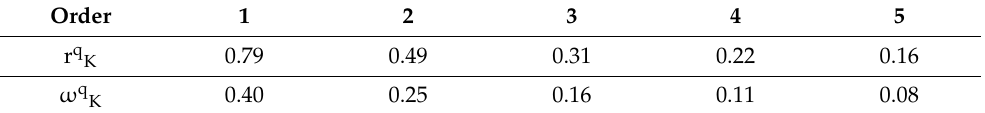
Table 12. Correlation coefficient and weight factor of each order of the improved grey Markov model. Order